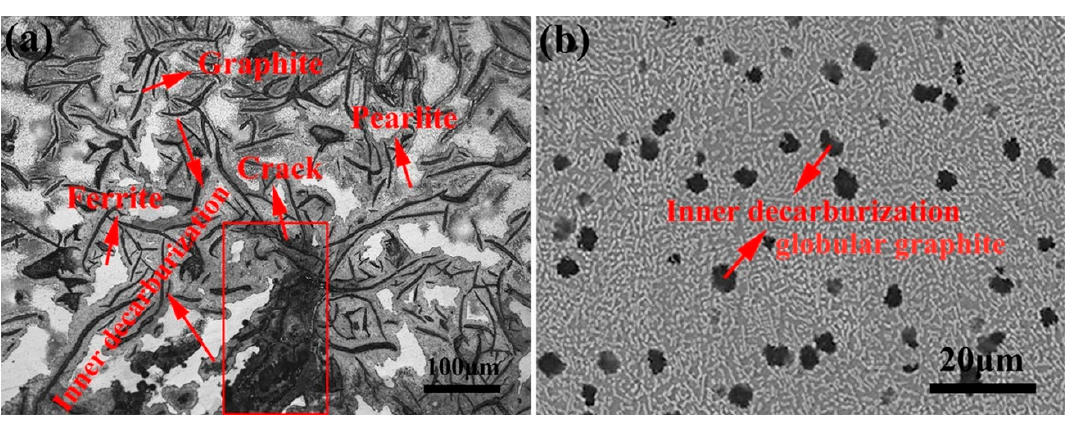
Figure 14. Microstructure of the cross sections of specimen after thermal 600 cycles. ( a ) the substrate; ( b ) the bionic unit. Metals 2020 , 10 , x FOR PEER REVIEW 15 of 20